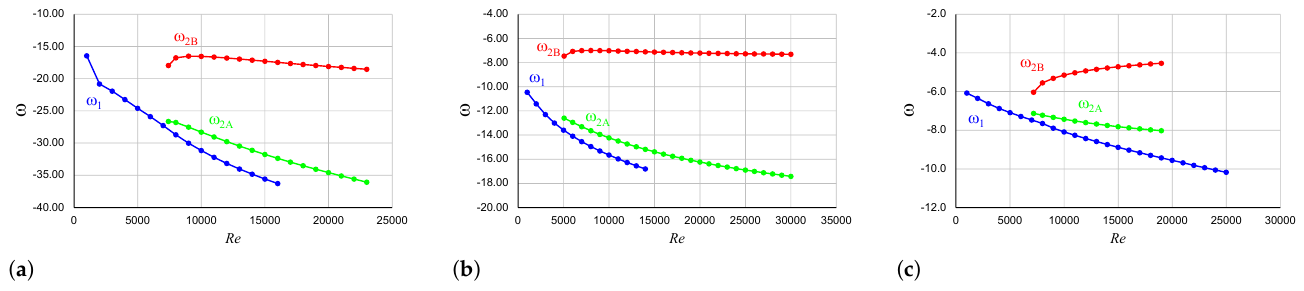
Figure 19. Variation of vorticity values at the center of the local vortex centers in 1st and 2nd solutions with respect to the Reynolds number with color codes blue, red and green. ( a ) Vorticity ( ω ) values, D = 0.26. ( b ) Vorticity ( ω ) values, D = 0.5. ( c ) Vorticity ( ω ) values, D = 0.8.